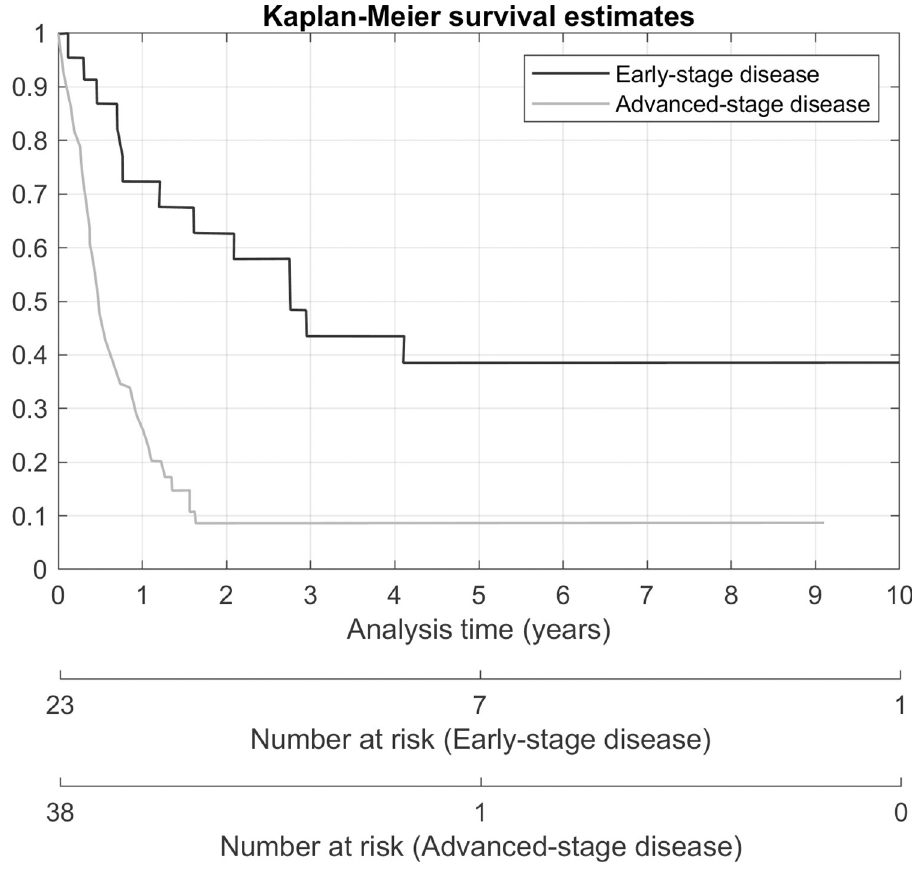
Fig 2. Overall survival according to the stage of